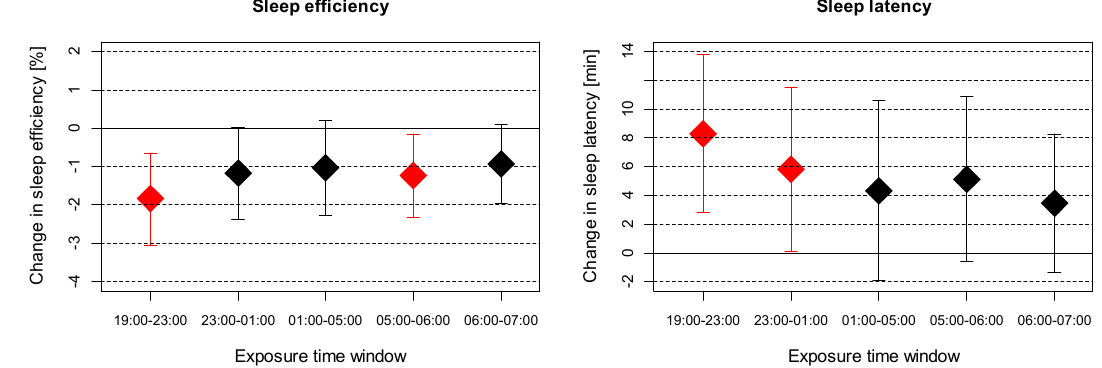
Figure 1. Association between measured outdoor noise exposure (L eq ) at different time windows during night and changes in all-night sleep efficiency and sleep latency per 10 dB(A) increase in noise exposure. Significant associations are highlighted in red. Analyses adjusted for age, sex, education, evening caffeine intake, evening alcohol consumption, evening screen time, day of the week, season, and whether woken up by an alarm clock.